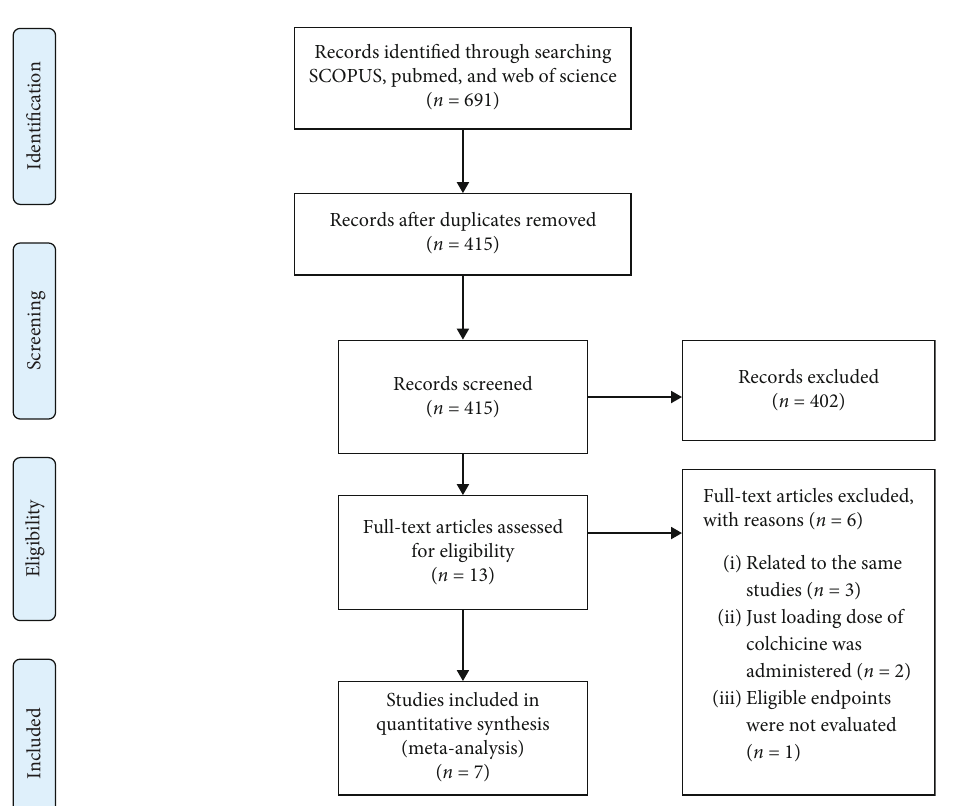
Figure 1: PRISMA fl ow diagram of study